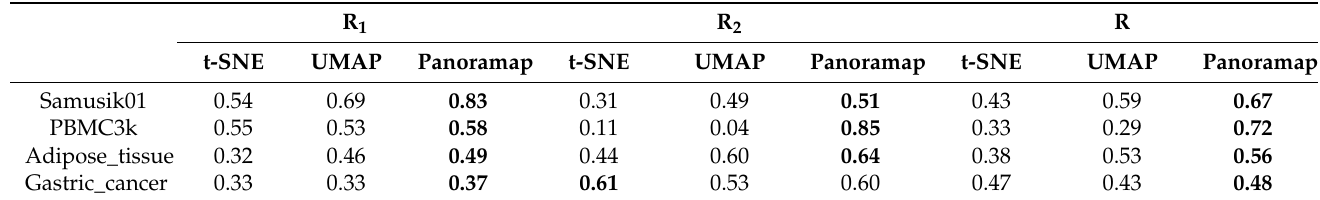
Table 1. Overview of evaluation metrics on the four datasets used in this study.